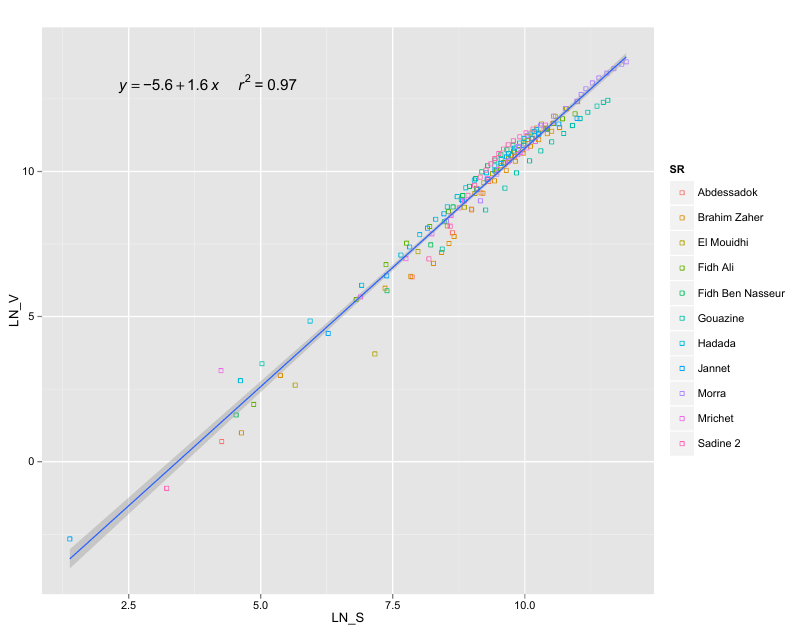
Figure 6. Relationship between surface area and volume based on rating curves from 11 small reservoirs and the interSR relation (blue line) derived from linear